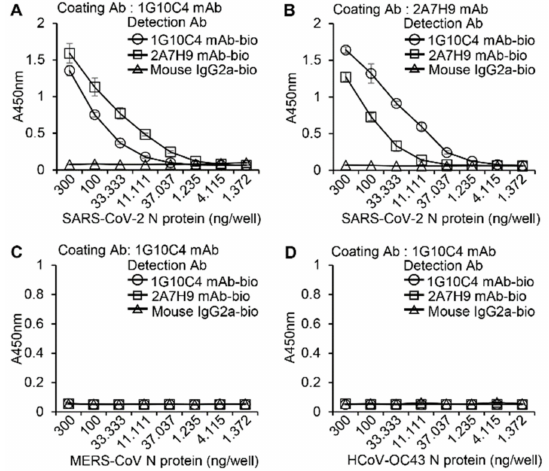
Figure 3. Specificity of the 1G10C4 mAb and 2A7H9 mAb for recombinant SARS-CoV-2 N protein. ( A , B ) Ninety-six-well immuno plates were coated with 100 ng/well of 1G10C4 mAb ( A ) or 2A7H9 mAb ( B ), and then serially diluted recombinant SARS-CoV-2 N-His 6 protein was added. ( C , D ) Ninety-six-well immuno plates were coated with 100 ng/well of 1G10C4 mAb before the addition of recombinant MERS-CoV N-His 6 protein ( C ) or recombinant HCoV-OC43 N-His 6 protein ( D ). Subsequently, 100 ng/well of the biotinylated 1G10C4 mAb, 2A7H9 mAb, or mouse IgG2a mAb was added, and a titration curve was obtained by an ELISA using peroxidase-conjugated avidin